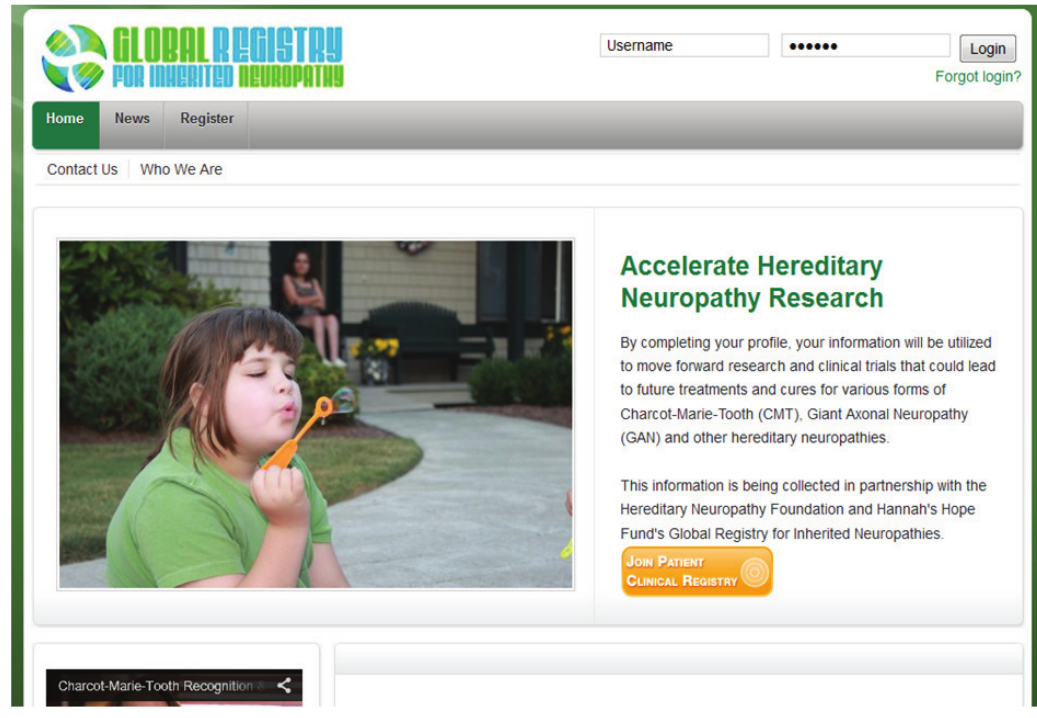
Supplemental Figure 1. Website landing page for Global Registry for Inherited Neuropathy